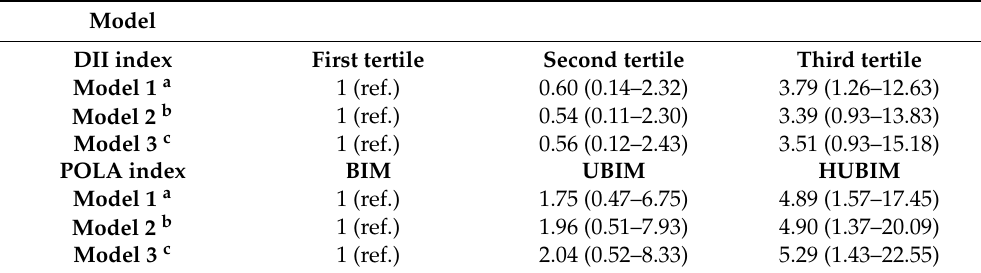
Figure 2. Incidence of COVID-19 in relation to the DII. The risk of COVID-19 according to the categories of the DII and POLA index is shown in Table 5. Participants in the third DII tertile showed almost four-fold greater odds of COVID-19 in a crude model, compared with participants in the lowest DII tertile. However, the difference was no longer significant after adjustment for the type of diet, sex, marital status, age, body fat percentage, smoking, and the presence of Escherichia coli . Based on the POLA index, the BIM diet group showed about 80% lower odds of COVID-19 than the HUBIM diet group. The result remained significant regardless of the level of adjustment (OR = 5.29, 95%CI: 1.43–22.55 for HUBIM vs. BIM in the fully adjusted model). Table 5. Relationship between the risk of COVID-19 and the tertiles of DII and POLA